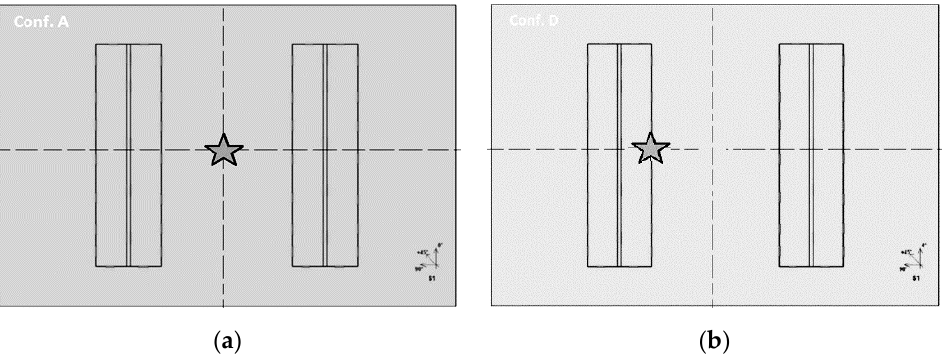
Figure 4. Impact position indicated by a star: PNL1 panel in the center of the skin ( a ); PNL2 panel under a stringer ( b ).